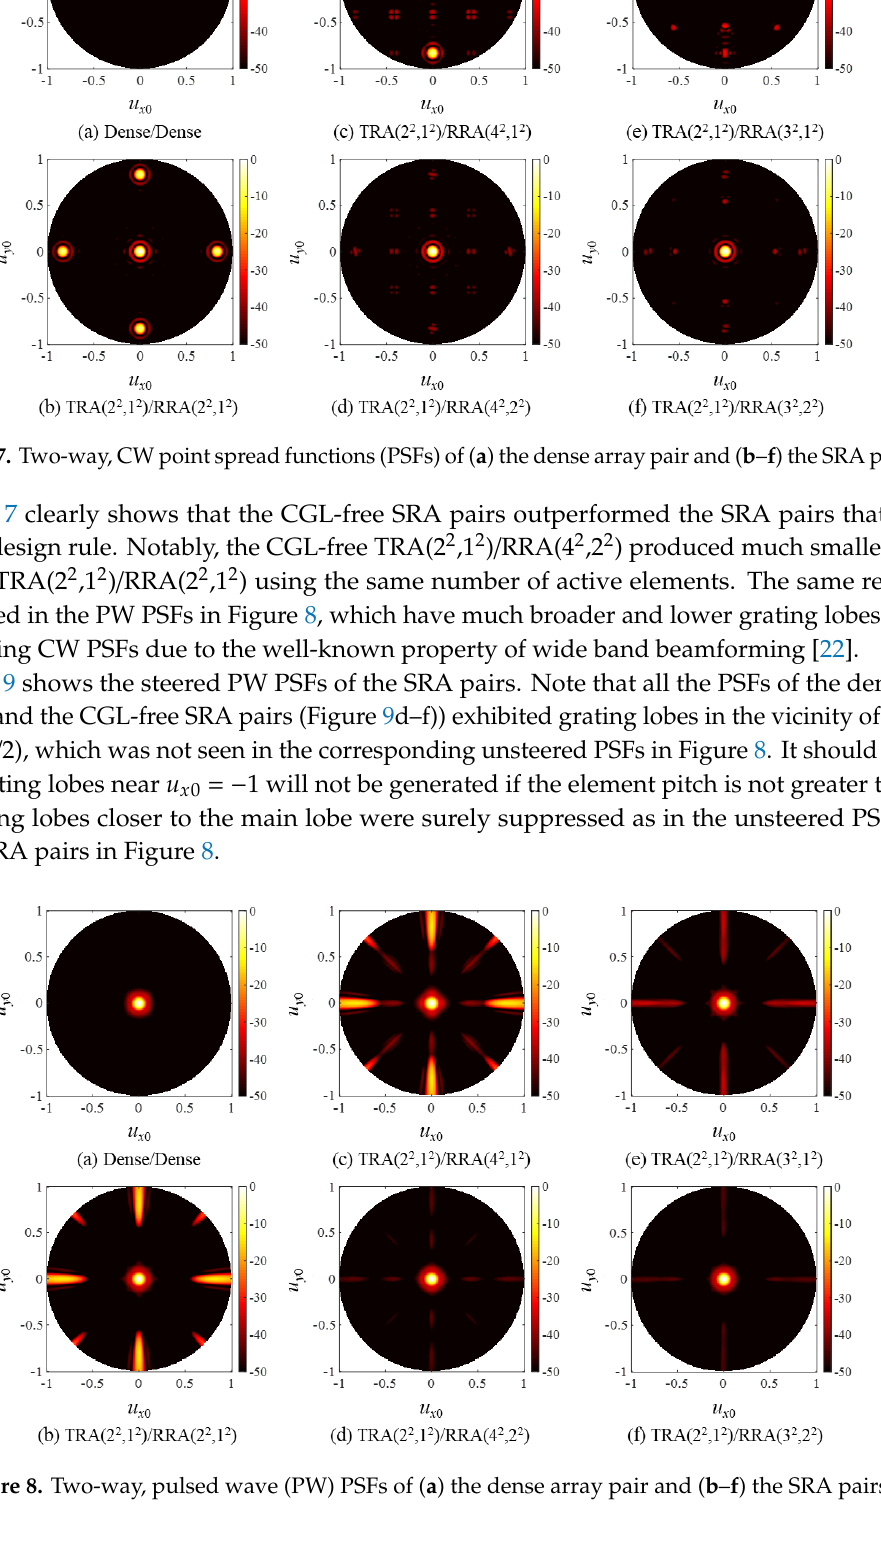
Figure 9. PW PSFs of ( a ) the dense array pair and ( b – f ) the SRA pairs for a steered focal point at ( u x f , u y f ) = (0.5,0) (i.e., θ f = π/6, and φ f = 0).